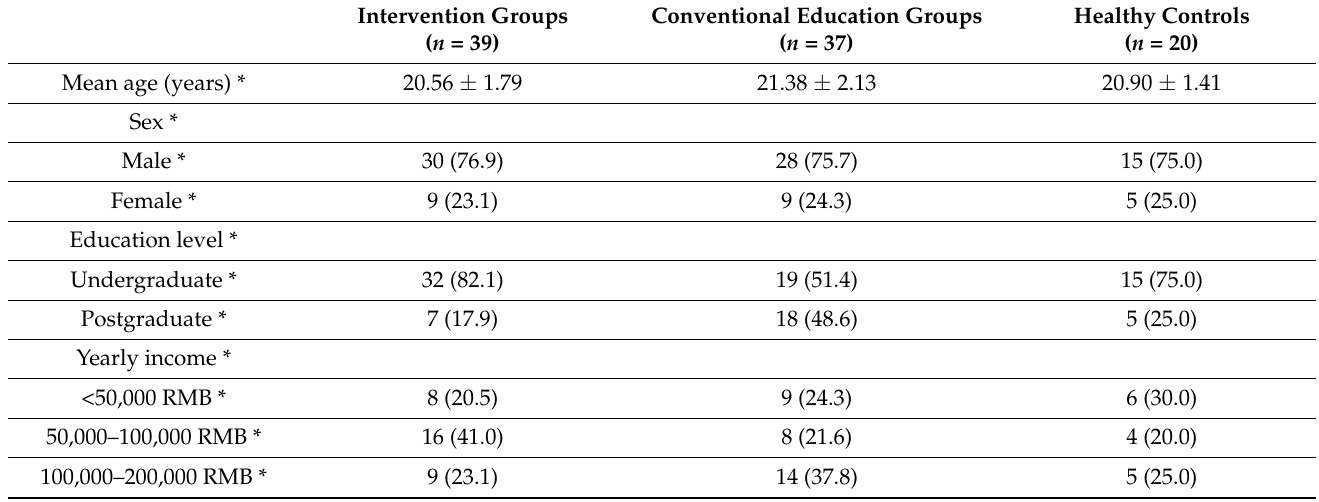
Table 2. Demographic data of participants at